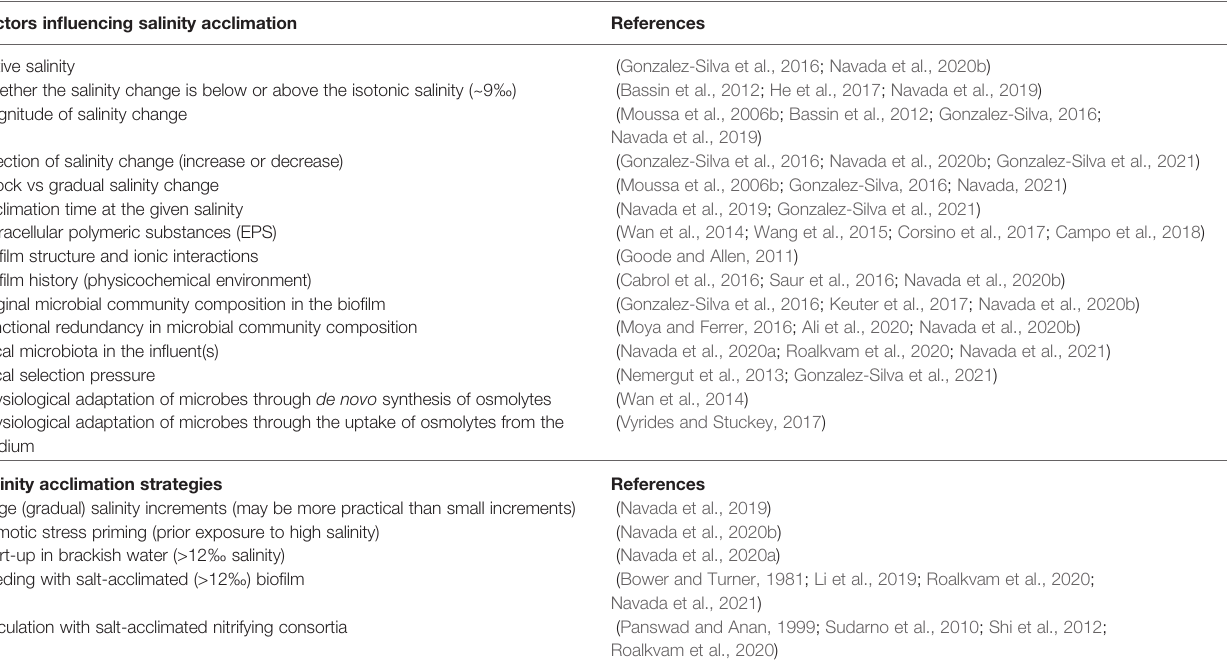
TABLE 2 | Factors in fl uencing salinity acclimation and feasible salinity acclimation strategies for nitrifying